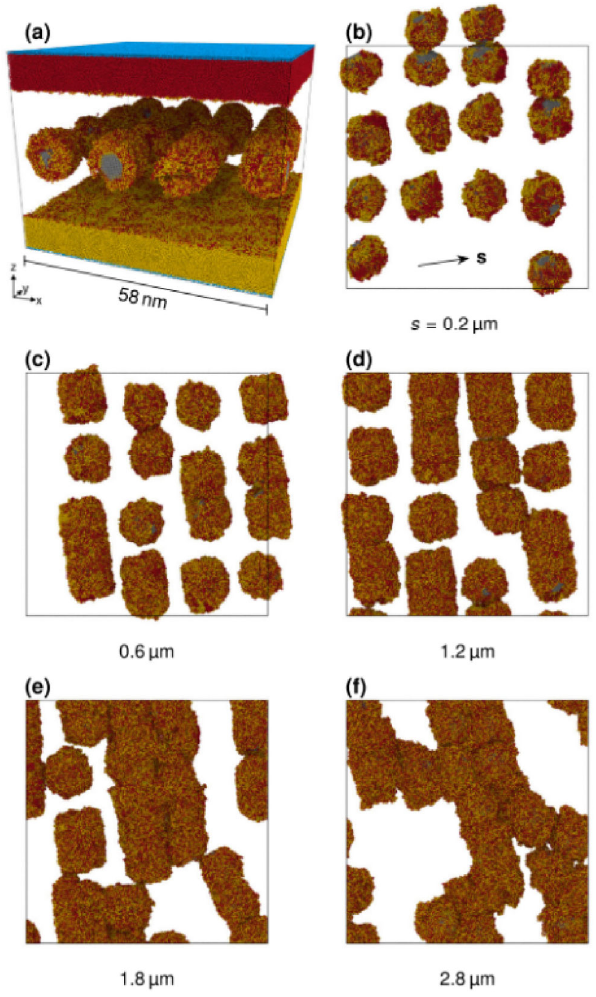
Fig. 79 Evolution of wear particles. (a) Particles were introduced between two surfaces and subjected to sliding motion. (b)–(f) Wear particles evolve from spherical particles in (b) to cylindrical rollers (c) and (d), to a porous, shear-band-like state in (e) and (f) [939]. Reproduced with permission from Ref. [939], © American Physcial Society,